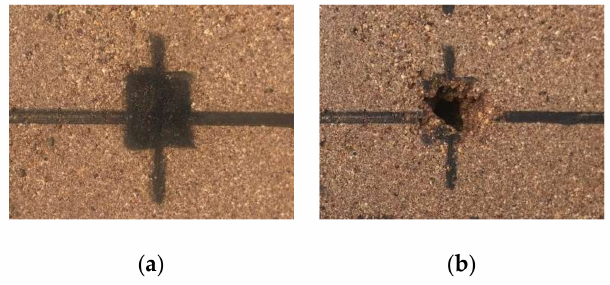
Figure 3. Refractory brick surface (black mark indicates erosion target area). ( a ) Before erosion, ( b ) after